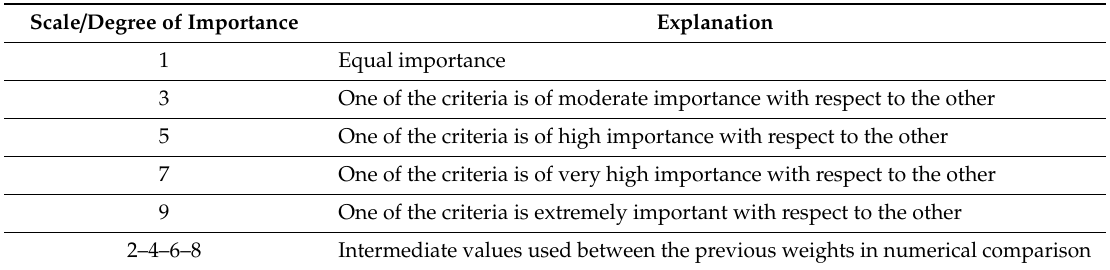
Table 4. Relative importance of criteria, according to Thomas Saaty.